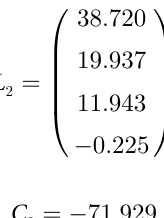
Fig 2. Box-and-whisker plots denoting the descriptive statistics for CEC, exchangeable Ca 2+ , exchangeable K + , exchangeable Mg 2+ , soluble Ca 2+ , medium sand, As, and Br, included in the discriminant analysis. Boxes indicate the standard deviations, whiskers the minimums and maximums, black circles the means, and horizontal lines the median. On the X-axis 1 = 0–50 mm layers; 2 = A horizons; 3 = B/B1/G/C1 horizons; 4 = B2/C/C2 horizons. Blue boxes represent sites with, while red boxes represent sites with no reported RVF mortalities [21]. Colored circles indicate extraneous values that were deleted.